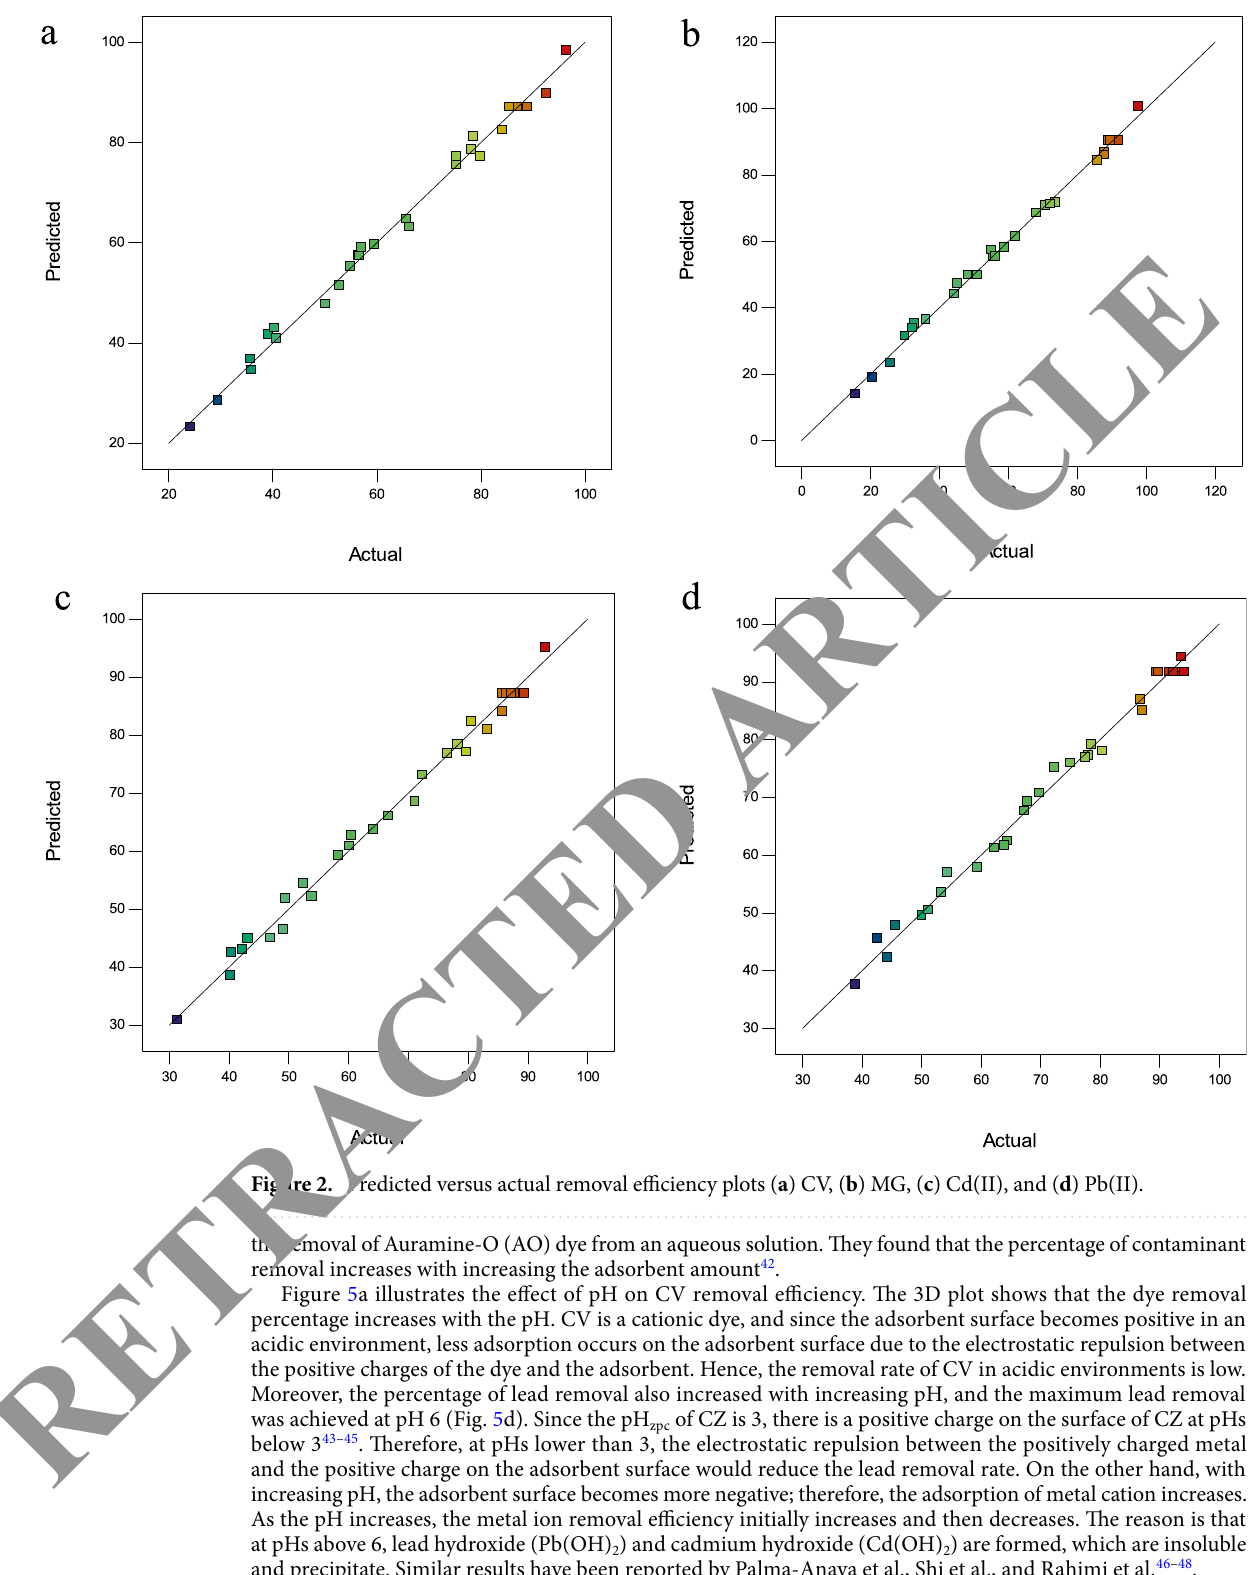
Figure 2. Predicted versus actual removal efficiency plots ( a ) CV, ( b ) MG, ( c ) Cd(II), and ( d )